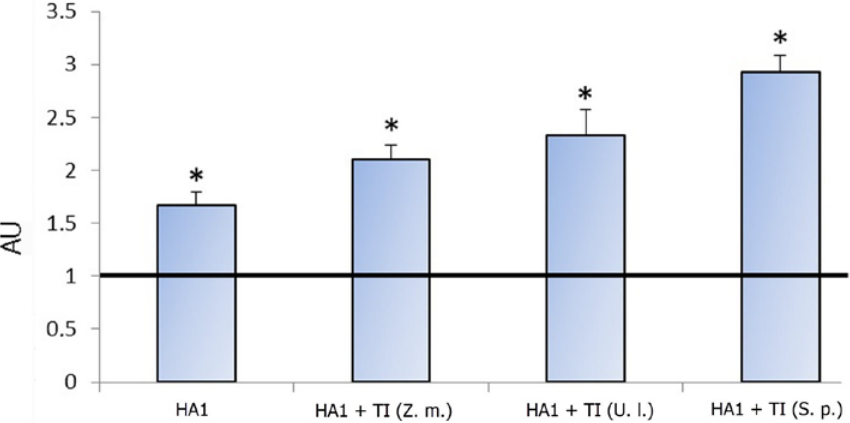
Figure 1. The content of anti-HA1 antibodies depending on the monogalactosyldiacylglycerol (MGDG) source. Antibodies were evaluated by ELISA in mice blood serum after two rounds of immunization by HA1 alone, HA1 incorporated in TI-complexes based on monogalactosyldiacylglycerol (MGDG) from Zostera marina ( HA1 + TI ( Z. m. )), Ulva lactuca (HA1 + TI ( U. l .)), or Sargassum pallidum (HA1 + TI ( S. p .)) at doses of 0.1 µg/mouse, administered subcutaneously at an interval of 14 days. The experiment was terminated 28 days after the first immunization. Control-mice were injected with phosphate-buffered saline (PBS). Each experimental group included six mice. The dilution of mice serum was 1/100. Data are expressed in arbitrary units (AU) relative to the control value equal to 1. Results are expressed as means ± SD of six observations. * p < 0.05 as compared with the control.